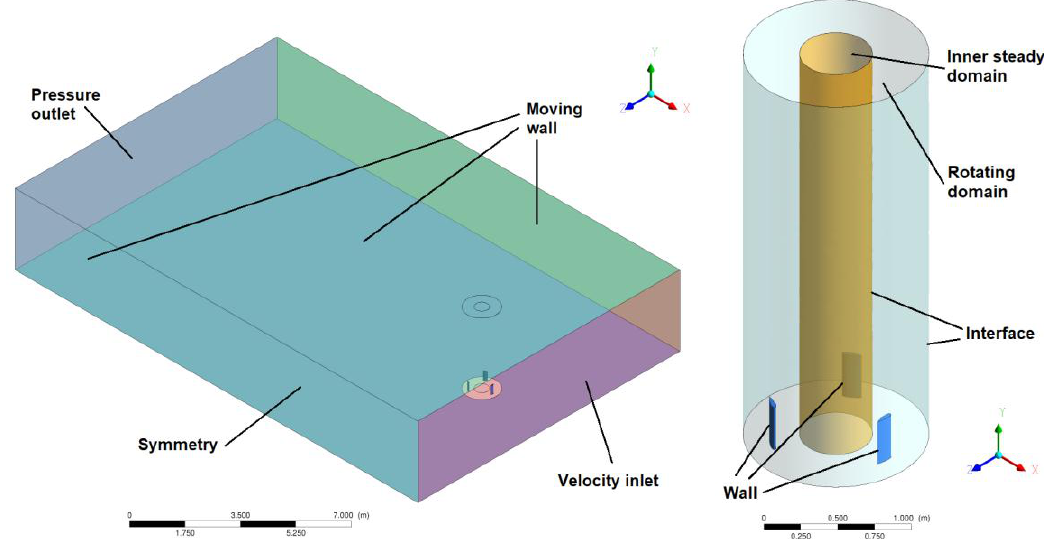
Figure 1. Computational domains employed in the CFWT simulation. Left : schematics of the full domain. Right : details of the rotating sub-domain enclosing the blades. Specified boundary conditions are also indicated in the plots.